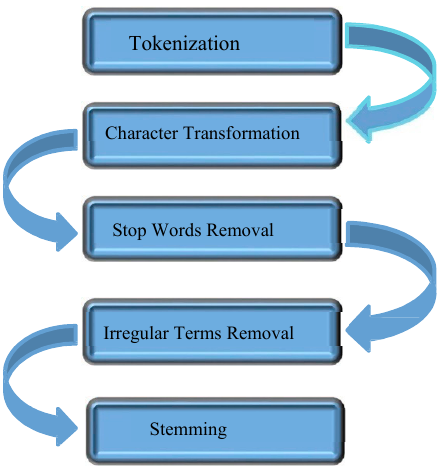
Figure 3. Data preprocessing steps .